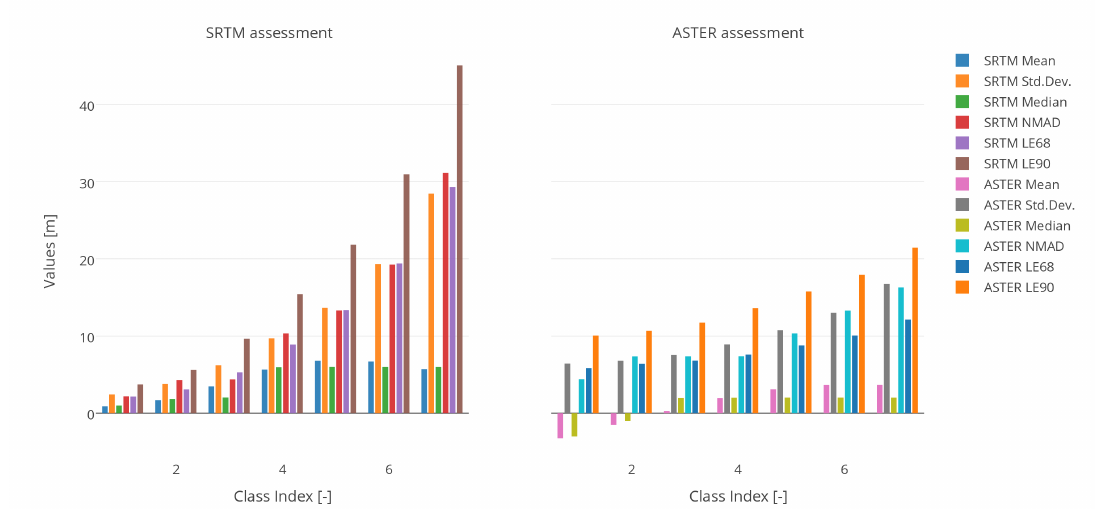
Figure 2: Colorado: SRTM and ASTER assessment